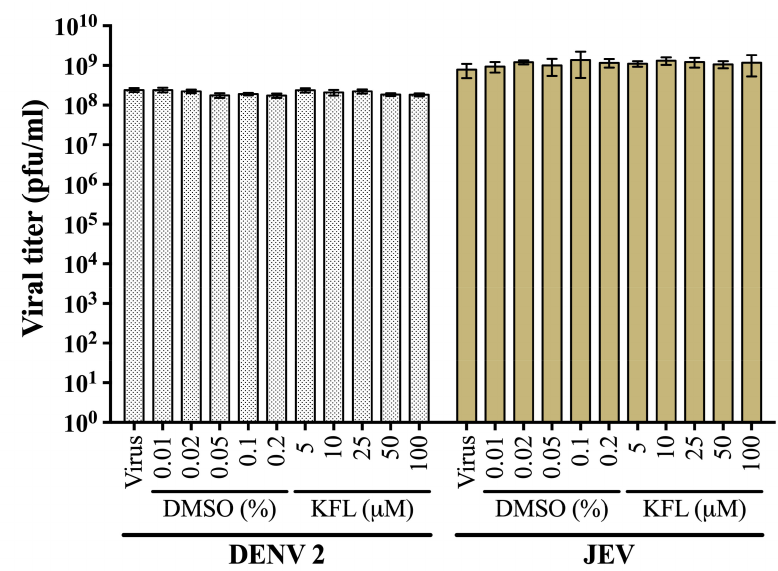
Figure 2. Analysis of direct virucidal activity against dengue virus 2 (DENV 2) and Japanese encephalitis virus (JEV). Either DENV 2 or JEV stock virus were directly incubated with various concentrations of kaempferol or corresponding concentrations of DMSO at 37 ◦ C for 1 h. Subsequently, viral titer in pfu / ml was determined by standard plaque assay. Experiment was performed independently in triplicate with duplicate plaque assay. Error bar shows mean ±